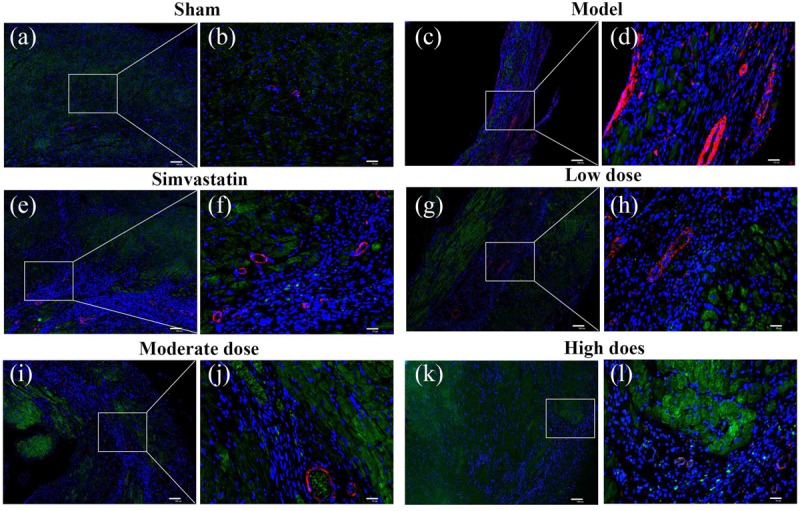
Representative distribution images of ERβ and α-SMA in rats treated with different doses of GXDSF. Immunofluorescence micrographs showing the differences in the distributions of ERβ and α-SMA in the infarct and per-infarct region in all experimental groups (a,c,e,g,i,k). Bars represents 100 μm. The right part of the figures (b,d,f,h,j,l) were augmented at 4-fold in the corresponding (the left) part of figures. In addition, the different quasi-colors were depicted for distinguishing ERβ and α-SMA, in which blue represented nuclei, green represented ERβ and red represented α-SMA.